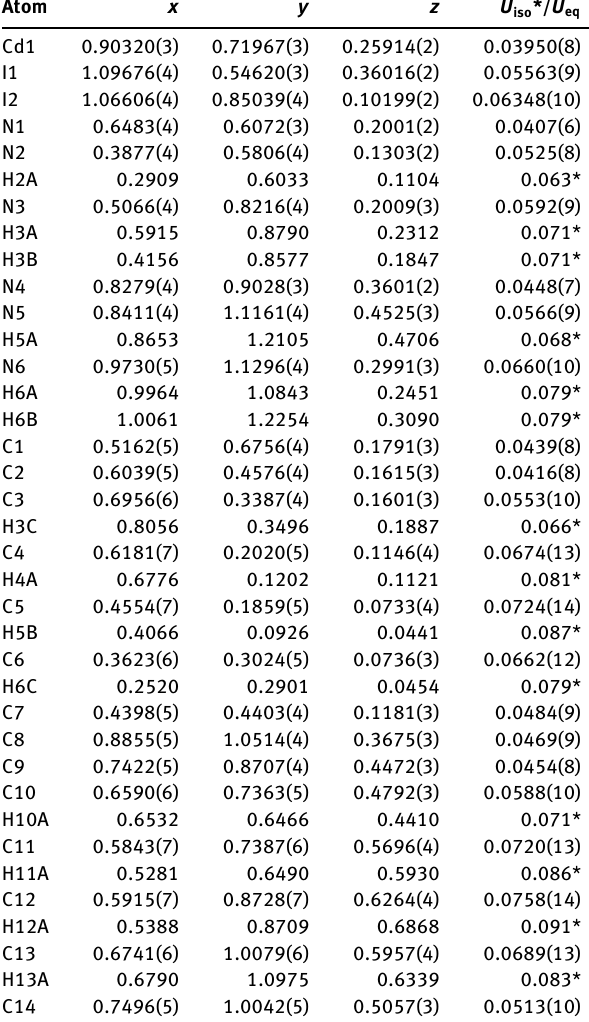
Table 2: Fractional atomic coordinates and isotropic or equivalent isotropic displacement parameters (Å 2